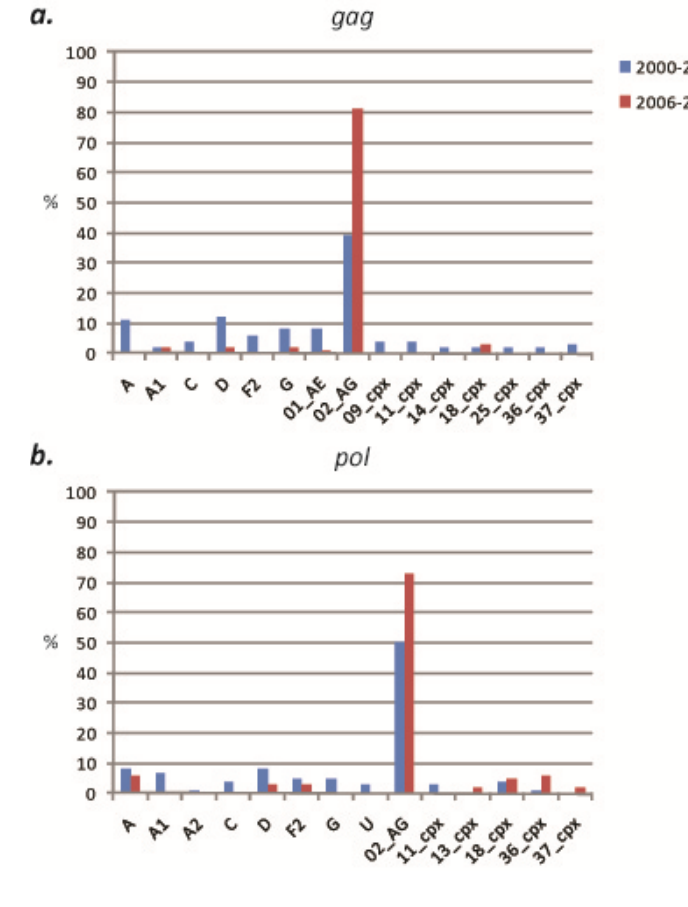
Figure 1. Percentages of each (sub)subtype and CRF at each locus, 2000–2001 and 2006–2008. (a) gag , 2000–2001 vs. 2006–2008. (b) pol , 2000–2001 vs. 2006–2008. (c) env, 2000-2001 vs. 2006–2008. Classifications are based on phylogenetic analysis using neighbor-joining and the Kimura 2-parameter method with bootstrapping (1000